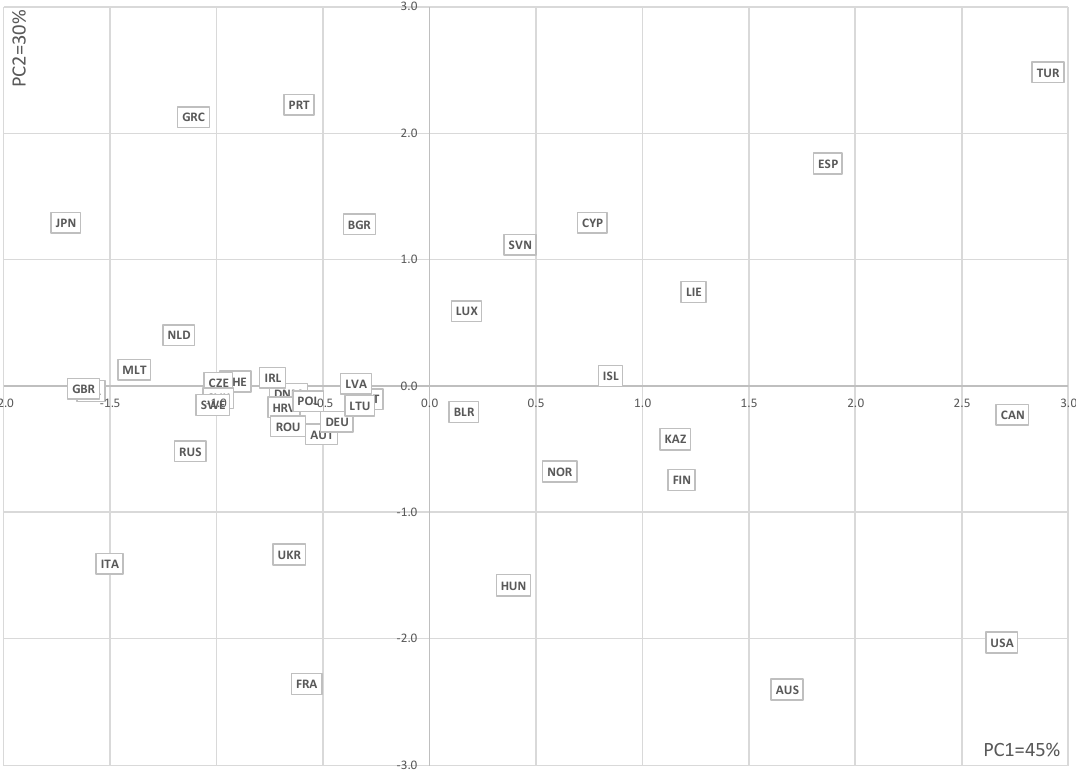
Figure 6. The representation of the trends in four main agricultural emission sources in the coordinate system created by the first and second principal components (PC1 and PC2).